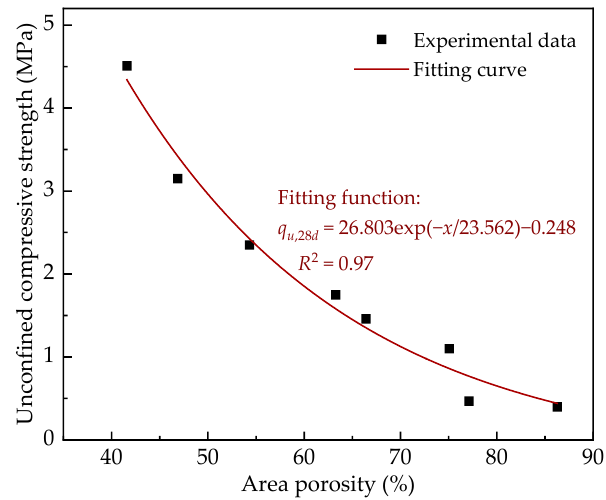
Figure 10. Fitting of experimental data of area porosity and unconfined compressive strength.